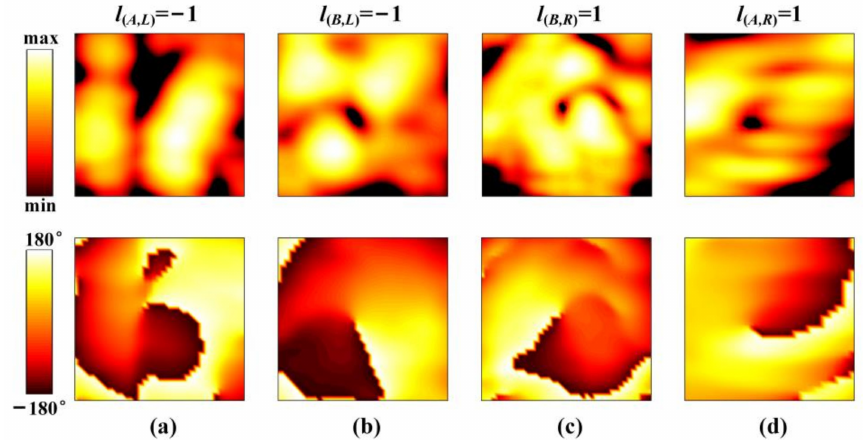
Figure 13. The measured magnitude and phase distributions at 10 GHz for four beams of different OAM modes at different directions. ( a ) l ( A , L ) = 1 at θ ( A , L ) = 30 ◦ , φ ( A , L ) = 72 ◦ . ( b ) l ( B , L ) = 1 at θ ( B , ◦ , φ ◦ . ( c ) l ◦ , φ ◦ . ( d ) l ◦ , − 1 at θ − 1 at θ L ) = 30 ( B , L ) = 150 ( B , R ) = ( B , R ) = 30 ( B , R ) = 252 ( A , R ) = ( A , R ) = 30 φ ( A , R ) = 330 ◦